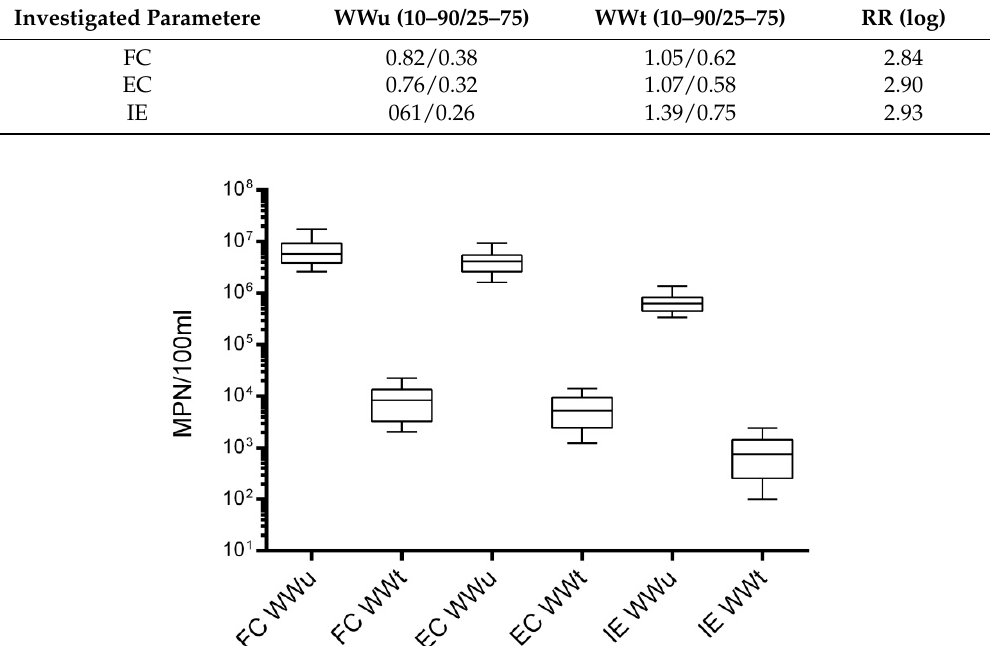
Figure 2. Concentrations of FC, EC and IE in the raw sewage sludge (SSr) and stabilized sludge (SSs), (N = 54).